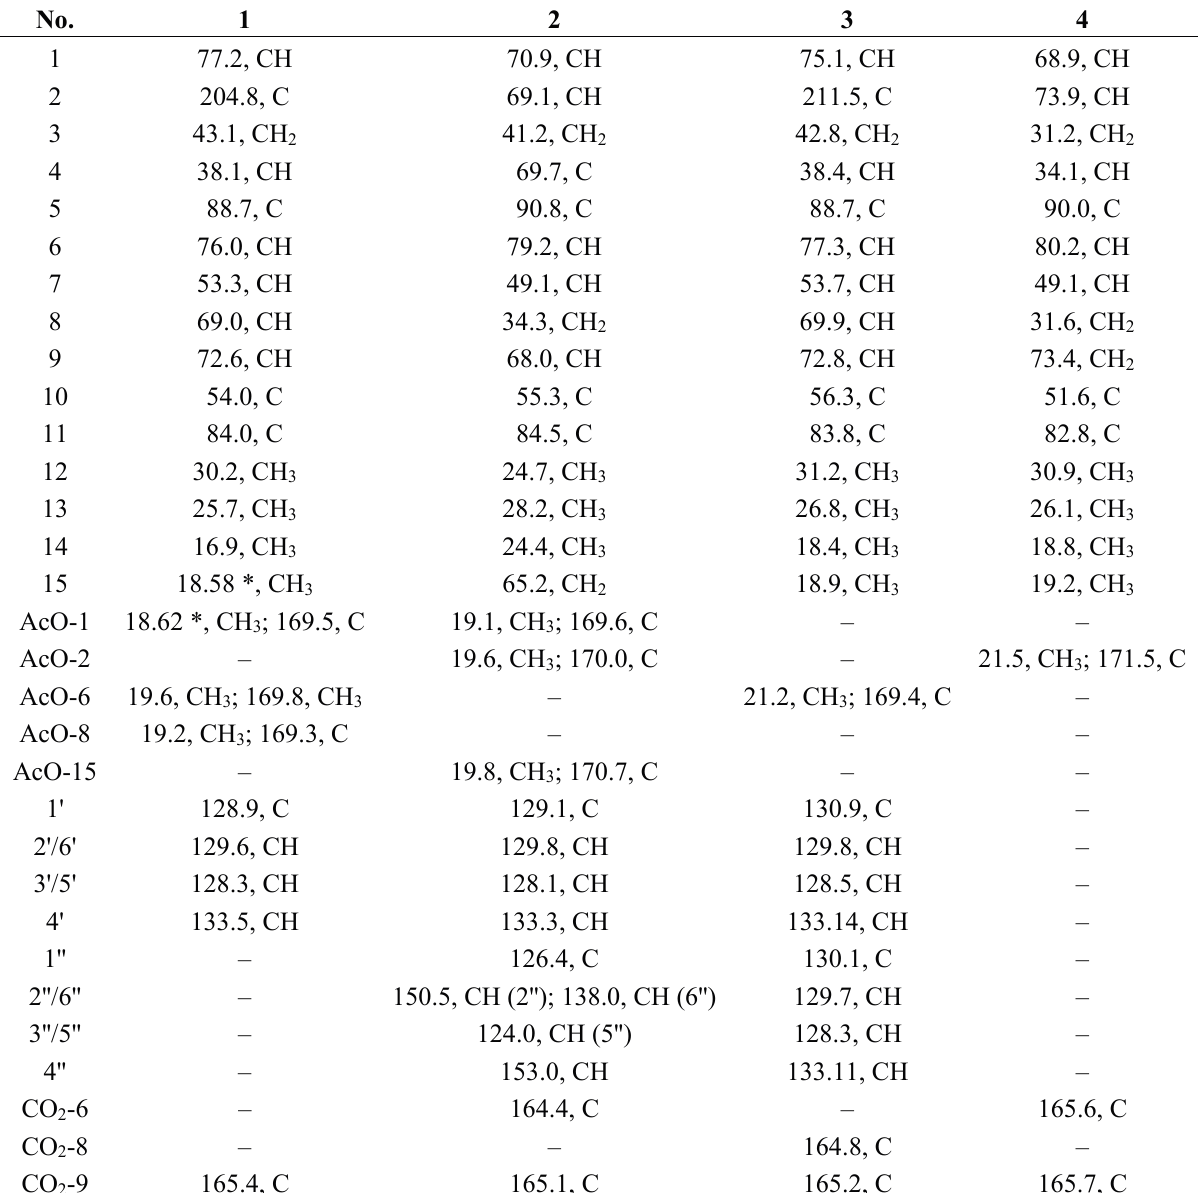
Table 2. 13 C-NMR and DEPT (Distortionless Enhancement by Polarization Transfer) data of compounds 1 – 4 (125 MHz; 1 and 2 : CD 3 OD; 3 and 4 : CD 3 Cl).